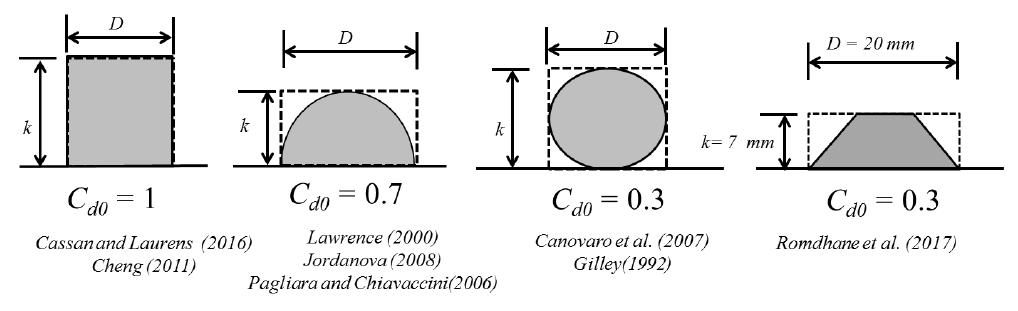
Figure 7. Comparison of roughness elements with the model assumption, i.e., vertically constant diameter D .